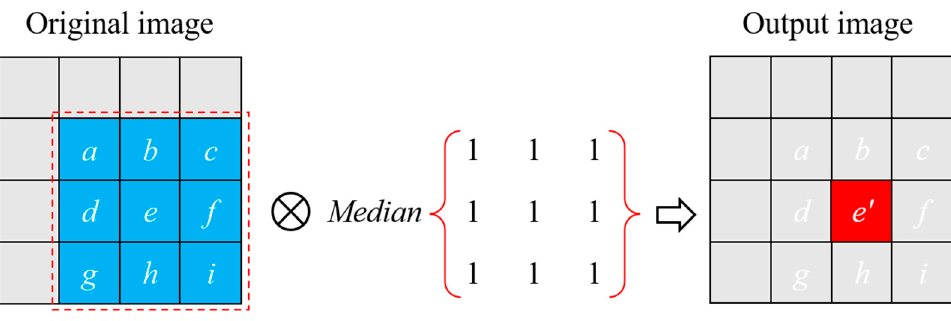
Figure 3. The principle of the Median filter. ⨂ is defined by where a , b , …, i are the values of the pixel of the gray image; e ’ is the Median filter result of shape 3 × 3;